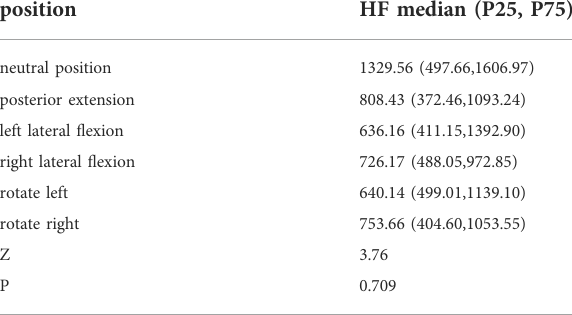
TABLE 4 HF Kruskal-Wallis H